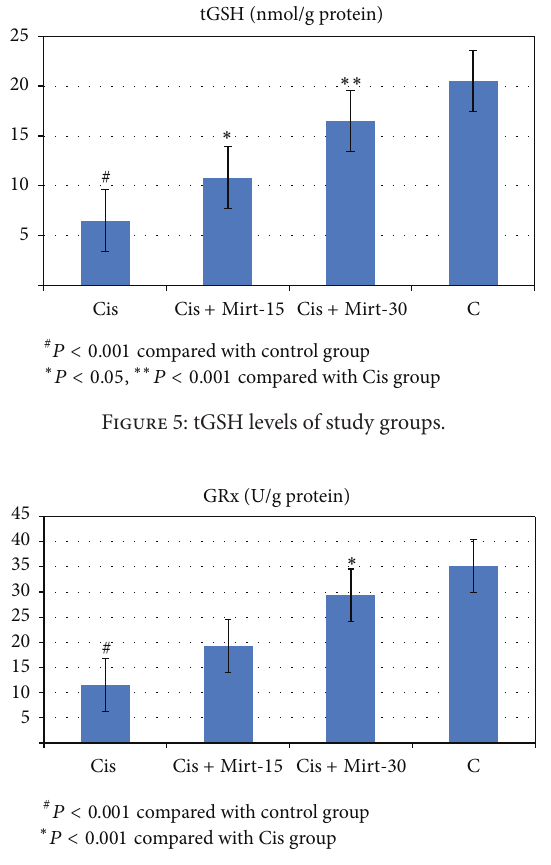
Figure 6: MPO activity of study groups.